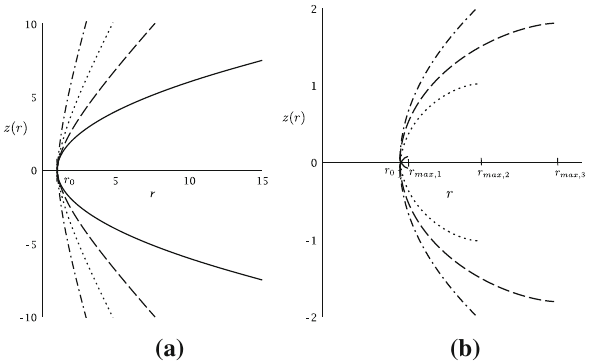
Fig. 2 In plot a embeddings of (6), exhibiting a solid angle deficit, for , 3 , 9 and β = 0 , 1 (solid, dashed, dotted and slices t = const ,θ = π 2 2 4 10 dash-dotted lines, respectively) are shown. For 0 ≤ β < 1 embeddings extend from r 0 to infinity. In plot b embeddings of Eq. (6) and β = − 1 , − 1 , − 15 (dashed, dotted and solid lines, respectively) are shown. 2 The dash-dotted line corresponds to β = 0. For β < 0 embeddings extend from r 0 to r max , i = r 0 (β − 1 ) β > r 0 , where i = 1 , 2 ,